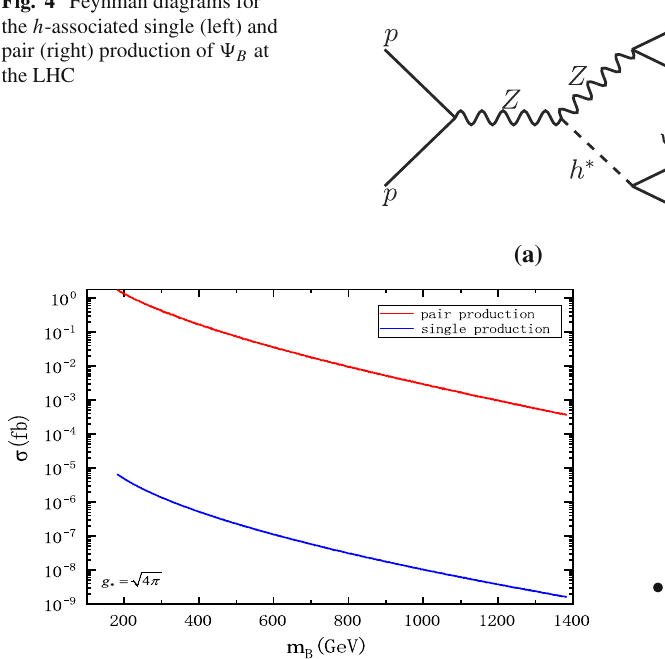
Fig. 5 Cross section of the single (in blue) and pair (in red) of (cid:8) B in Fig. 4 as function of m B at the 14-TeV LHC with g ∗ = Compared to the pair production, the cross section of single production is suppressed by the small mixing angles